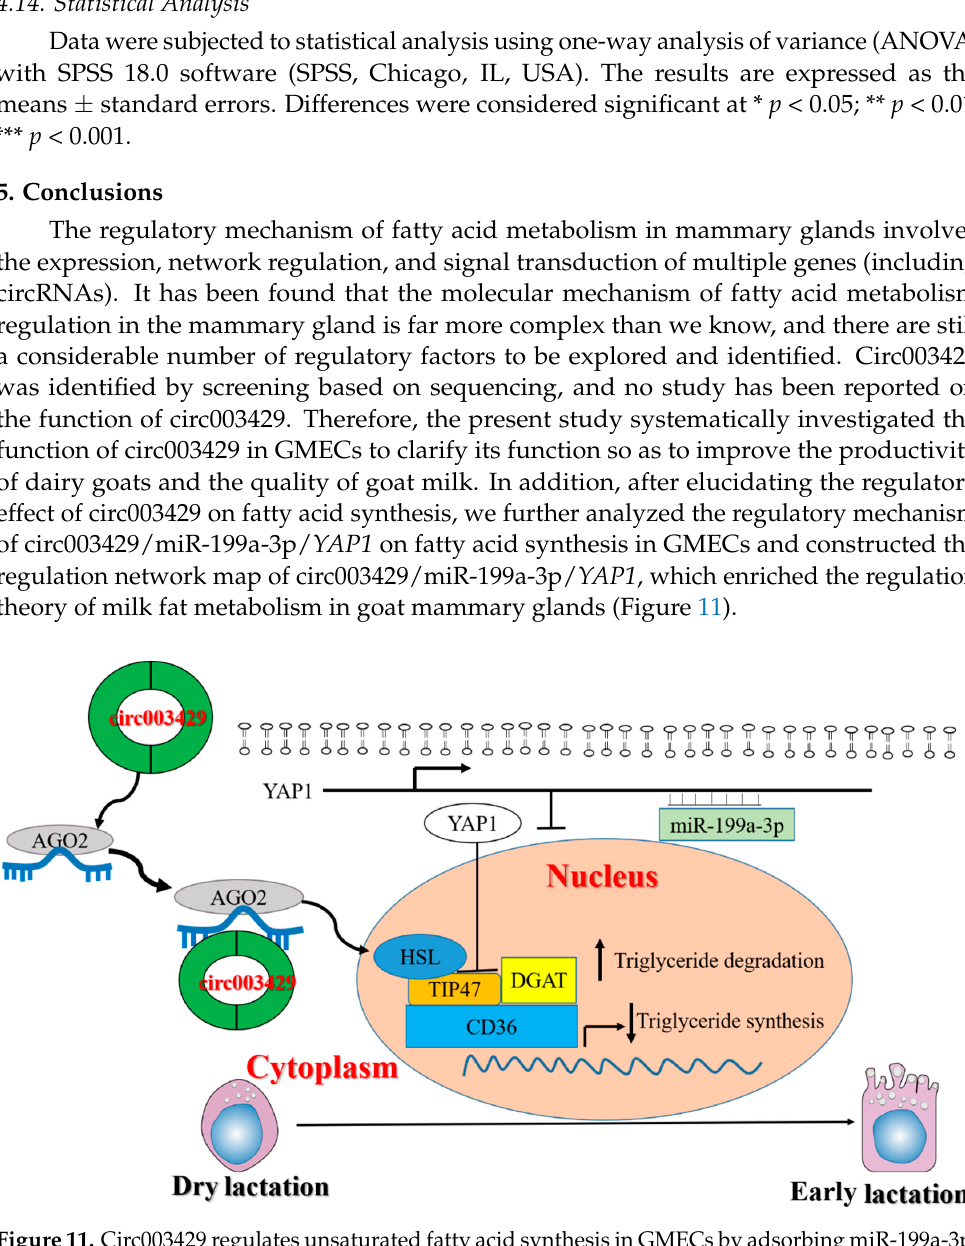
Figure 11. Circ003429 regulates unsaturated fatty acid synthesis in GMECs by adsorbing miR-199a-3p.